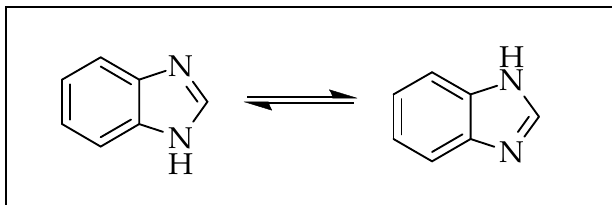
Figure 2. Structure of benzimidazole.